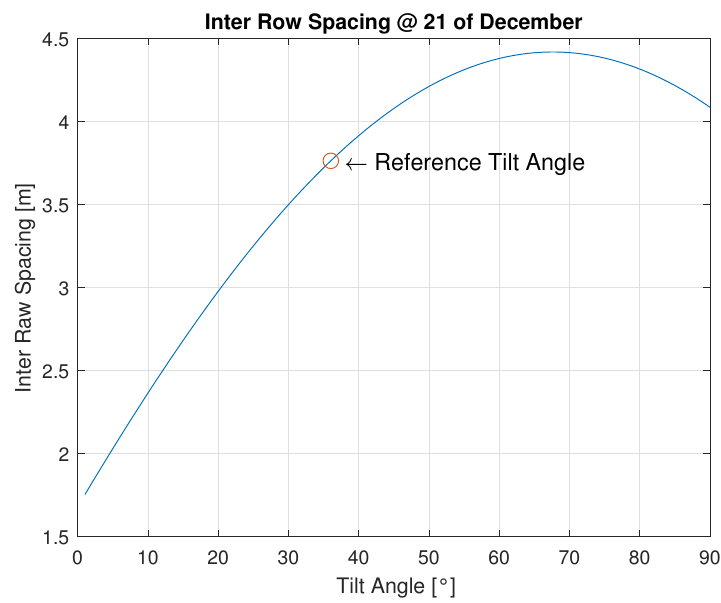
Figure 16. Inter row spacing at winter